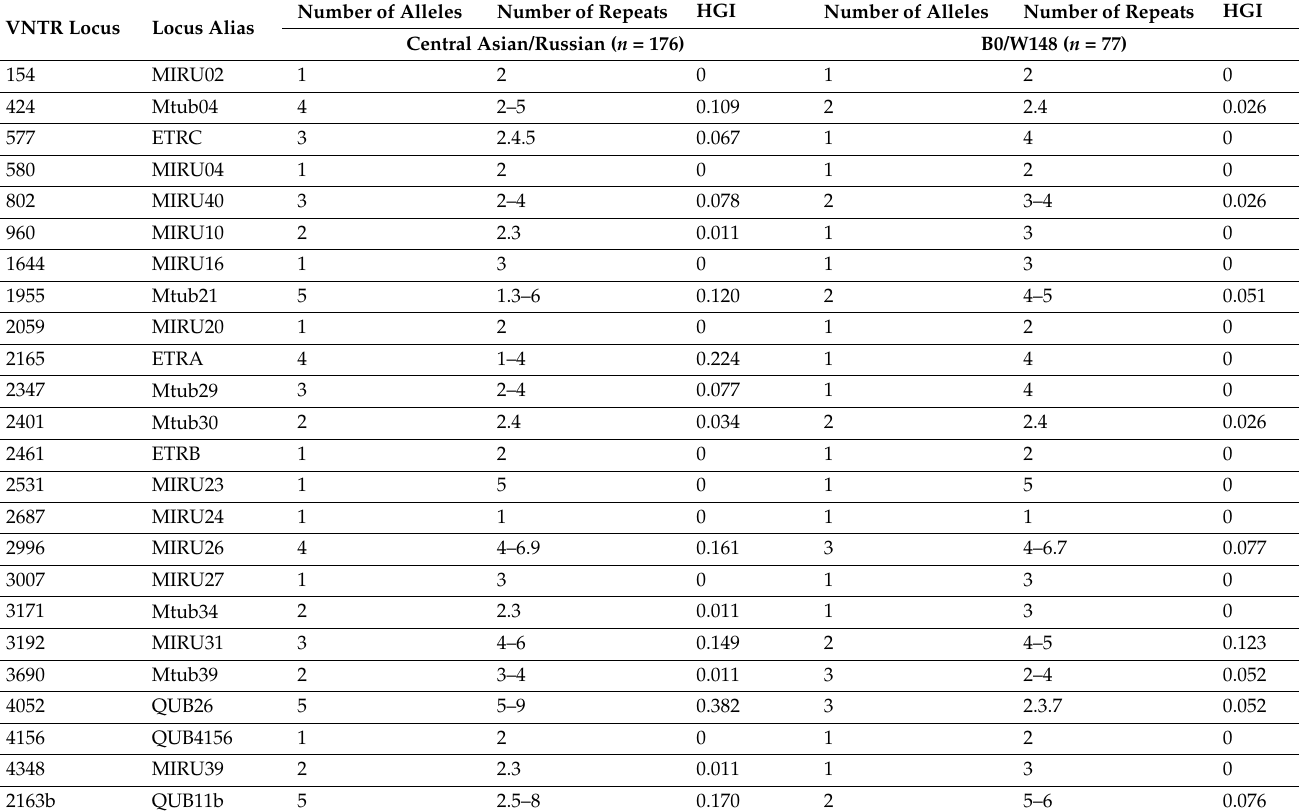
Table 2. Allele diversity of 24 MIRU-VNTR loci in M. tuberculosis strains Beijing Central Asian/Russian and